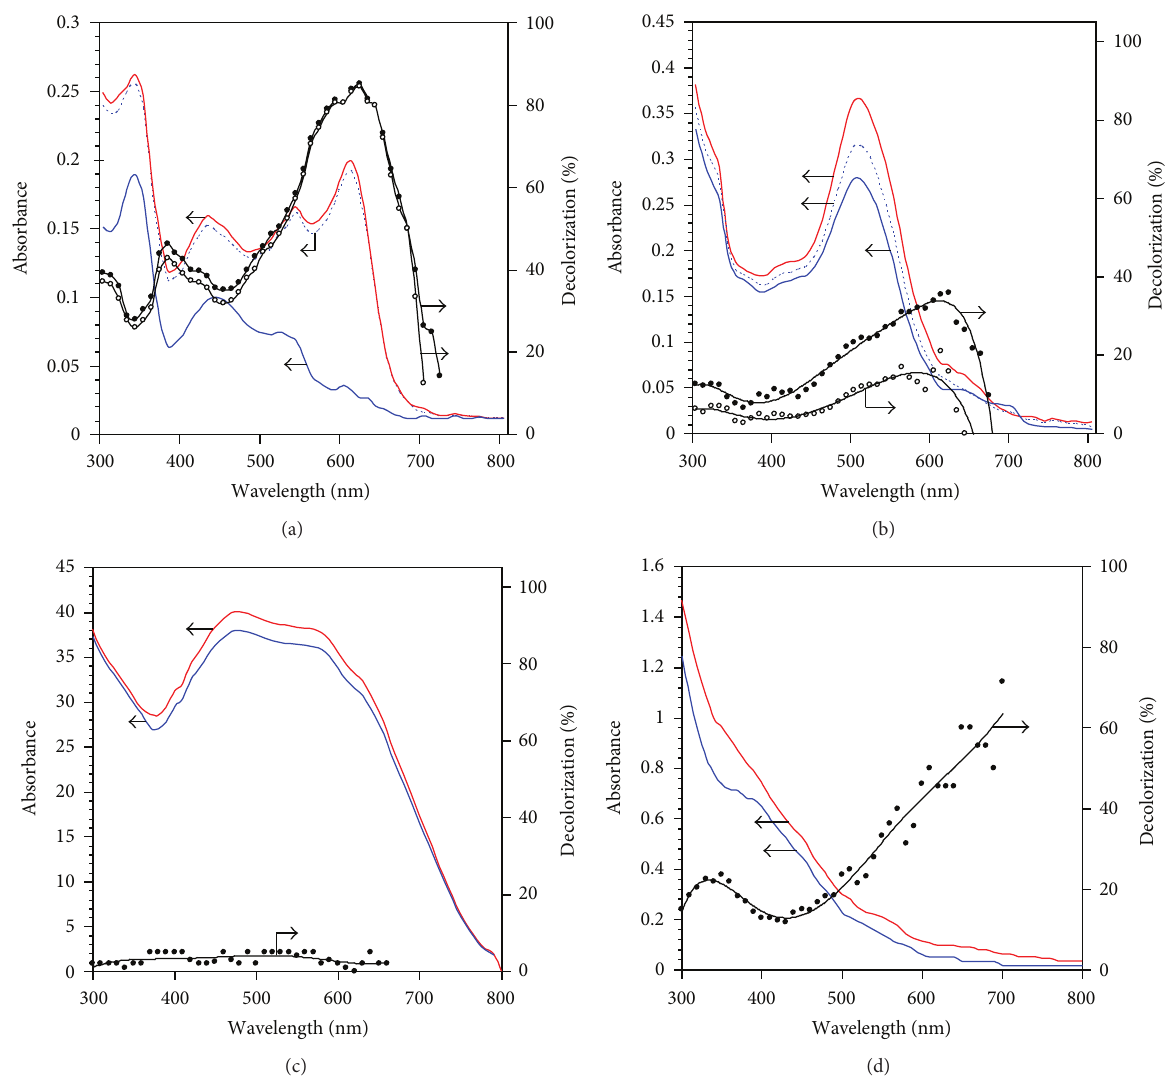
Figure 2: Absorption and decolorization spectra of WPac (a), WLeat (b), WFlax (c), and WCot (d). Solid line (red): initial spectrum of effluent, 𝐴 𝑜 ; dotted line (blue): effluent with TiO 2 , without UV-a irradiation, 𝐴 𝑌 ; solid line (blue): effluent with TiO 2 , after UV-a irradiation, −1 ) and after UV-a irradiation; ( ⃝ ) decolorization of effluent as a result of the ∙ ) total decolorization of effluent with TiO 𝐴 𝑍 ; ( 2 (2.5 gL photocatalytic process in the presence of TiO 2 (2.5g L −1 ) and after UV-a